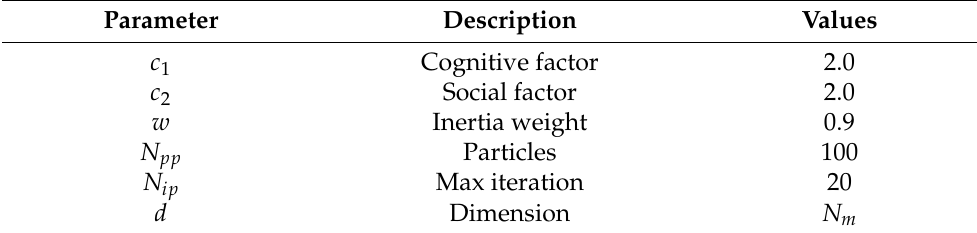
Table 2. Parameters of PSO.